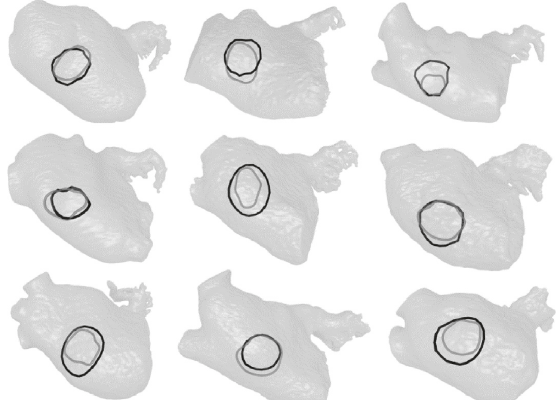
Figure 8: Fossa ovalis curves for nine randomly selected patients from the test dataset. The manually detected and the predicted curve are displayed in gray and black,